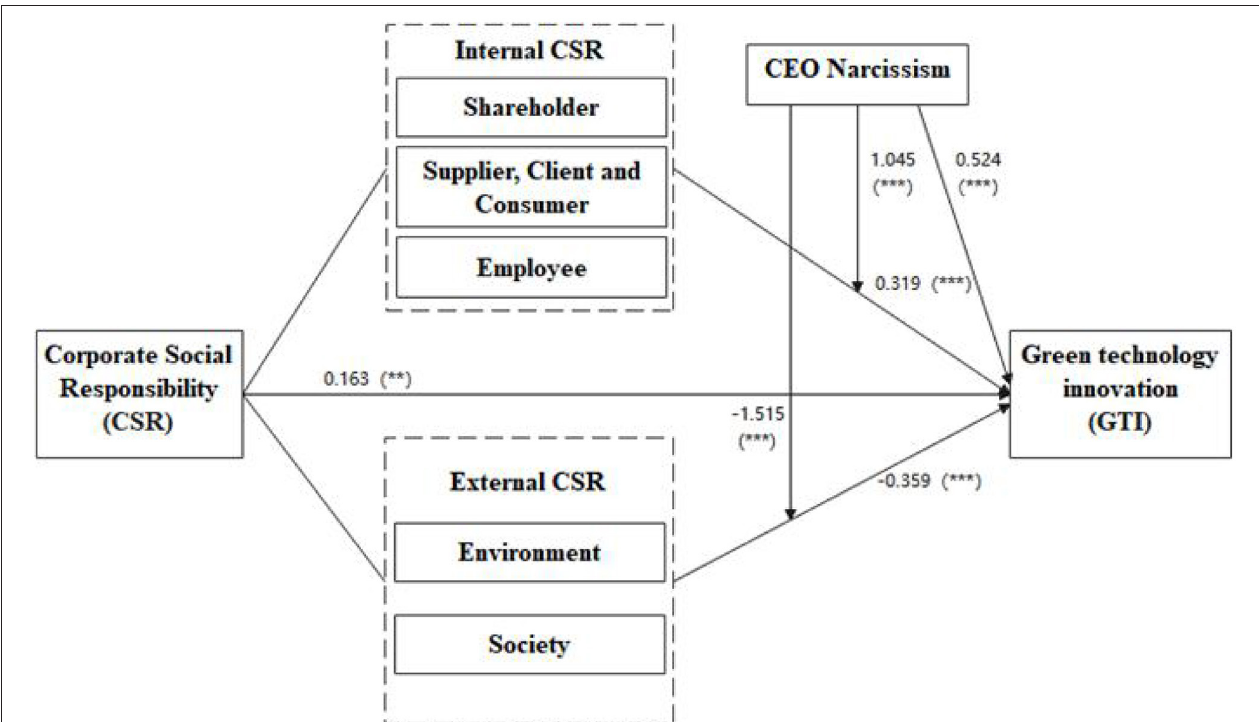
FIGURE 4 | Structural model of the